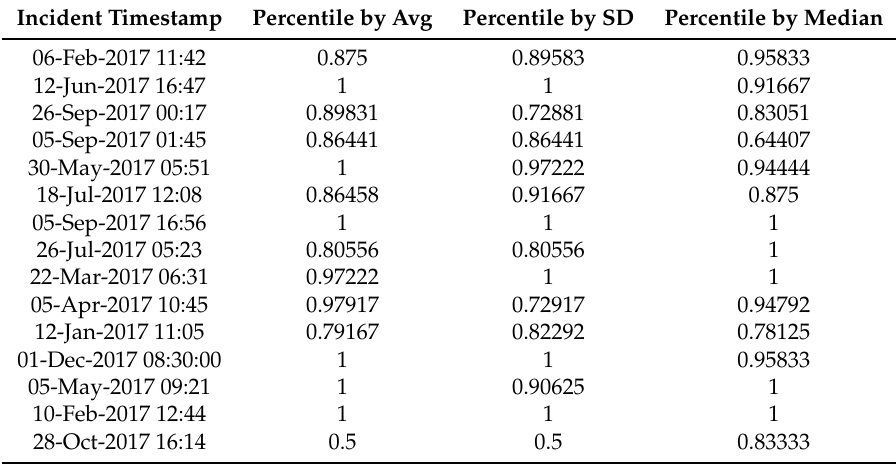
Table 4. Percentiles of incidents from the Phase 1-Train data when sorted by sensor, day of year, and time of day.